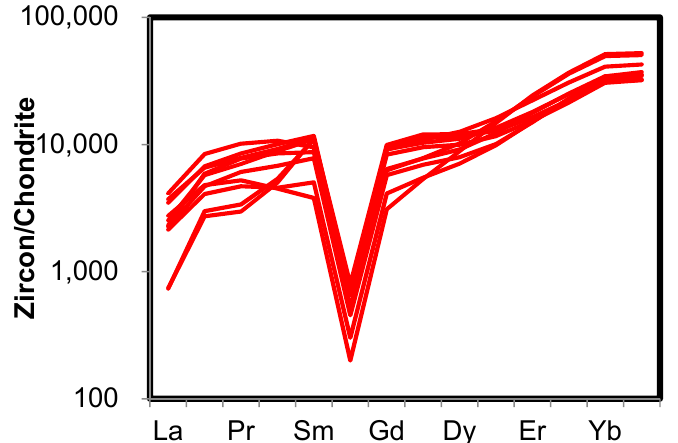
Figure 7. REE patterns of different phases zircons crystallized from marginal zone of pegmatite. Chondrite-normalized values are from McDonough and Sun [27] .